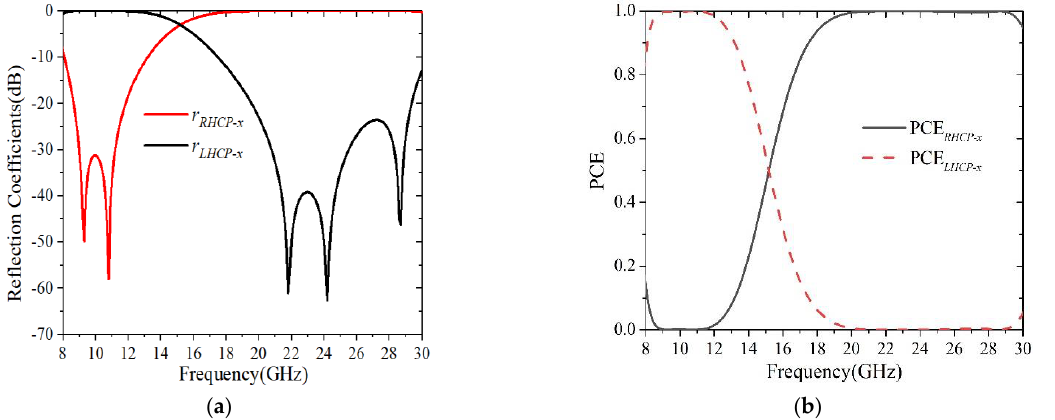
Figure 5. ( a ) Reflection coefficients of circular polarization conversion; ( b ) PCE of circular polarization conversion.